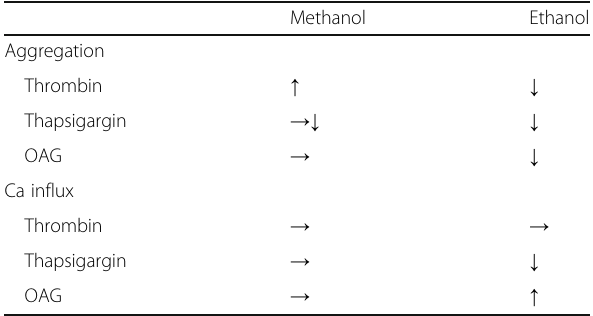
Table 1 Comparison of effects of methanol and ethanol on aggregation of and Ca 2+ influx into platelets induced by different stimulants Methanol Ethanol Aggregation Thrombin ↑ ↓ Thapsigargin →↓ ↓ OAG → ↓ Ca influx Thrombin → → Thapsigargin → ↓ OAG → ↑ ↑ increase; ↓ decrease; → no change